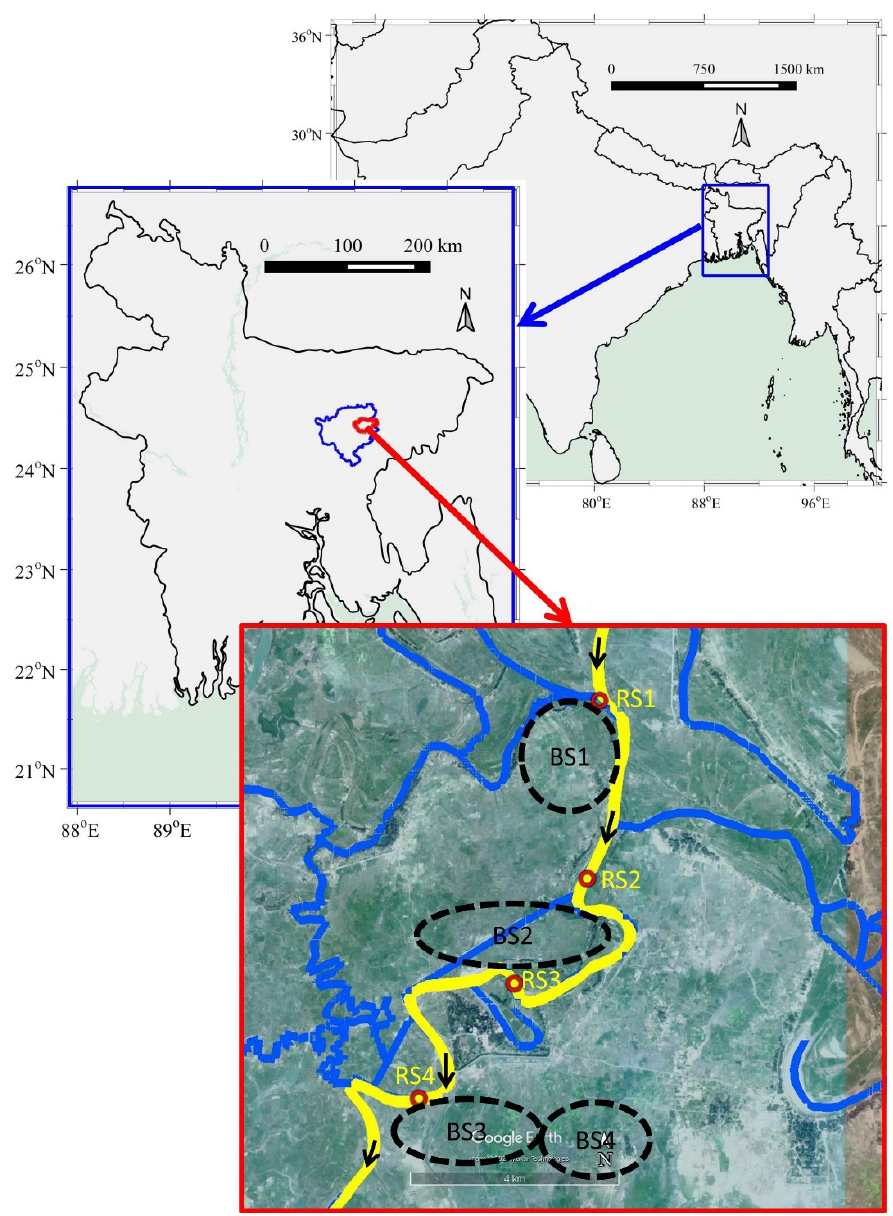
Figure 1. The inset showing the location of Bangladesh. In the enlarged map (bottom), sampled river sites (RS) are indicated by red circles, beel sites (BS) by black ovals, and minor rivers are shown as blue lines. The water flow direction is shown by black arrows on the Dhanu River (yellow line) (Google Earth Pro).